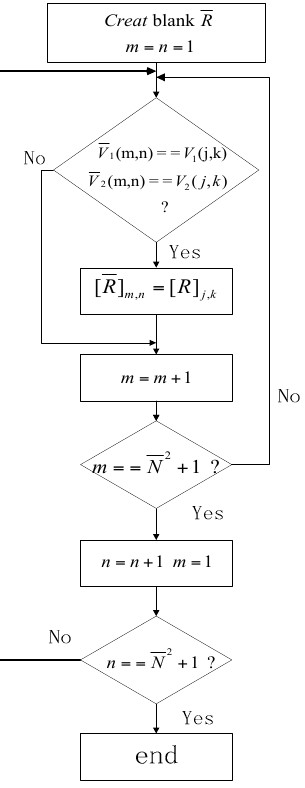
Figure 3. The diagram of the augmenting process. The principle of MVDR beamforming is minimizing the output’s variance while constraining the response of the desired signal to unity [18]. By using the augmented matrix R instead of R directly obtained from the received snapshot, we obtain a new MVDR beamformer with an optimal weight vector. Table 1. DOFs of the adaptive beamformer.